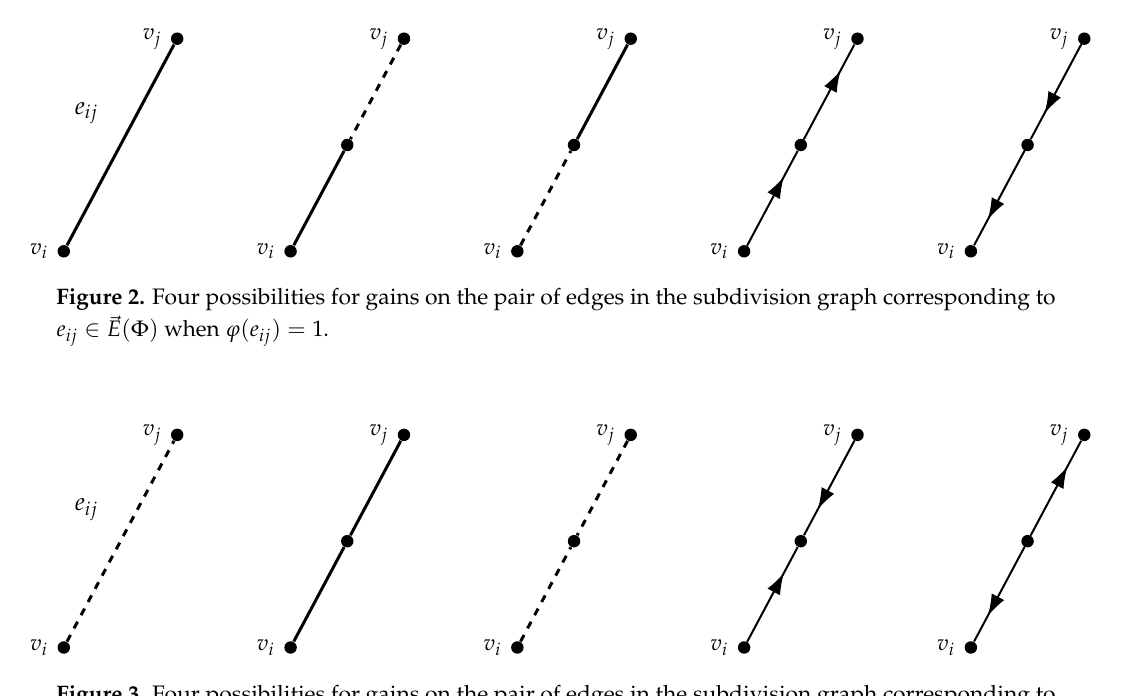
Figure 3. Four possibilities for gains on the pair of edges in the subdivision graph corresponding to e ij ∈ (cid:126) E ( Φ ) when ϕ ( e ij ) = − 1.